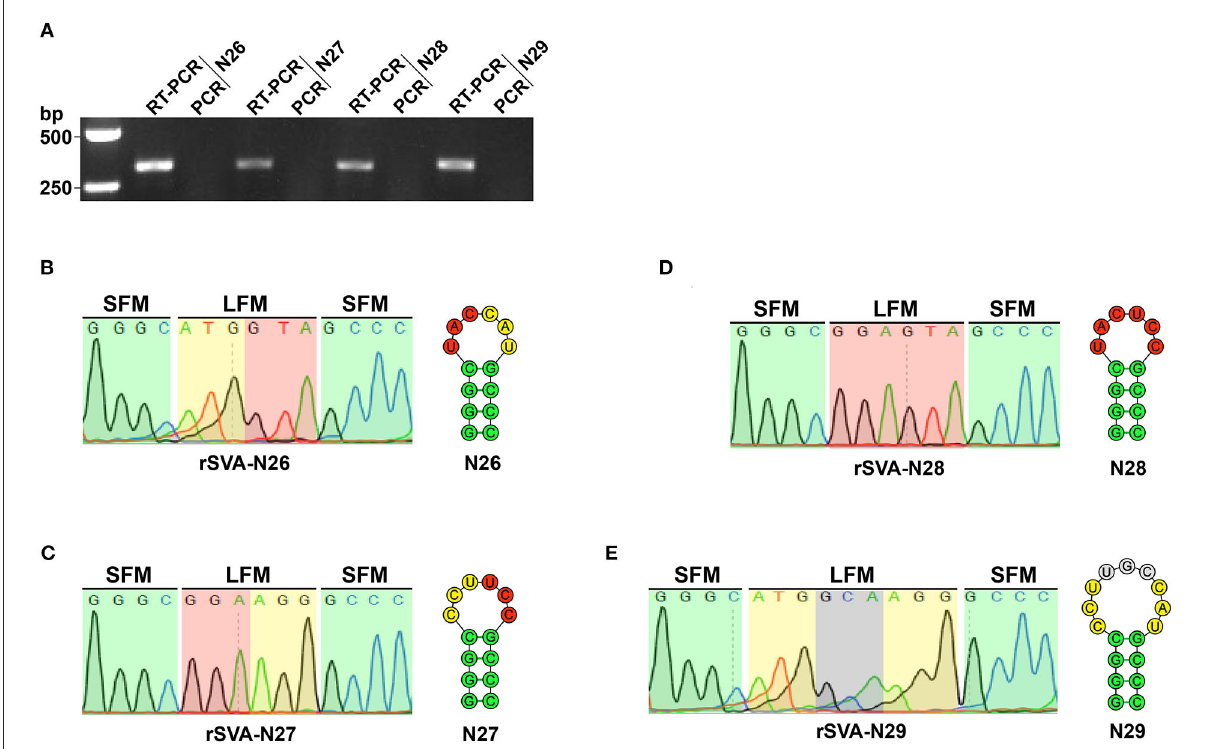
FIGURE6 Detection and characterization of rSVA-N26 to -N29. RT-PCR analysis of rSVA-N26 to -N29 at P6 (A) . PCR controls are assigned to demonstrate no interference of plasmid residues. Sanger sequencing for hairpin-1-forming motifs of rSVA-N26 to -N29 at P6 (B–E) . Since the reverse primer (RP4) is used for Sanger sequencing, four chromatogram-exhibited fragments are reverse-complement sequences of hairpin-1 motifs. Green, yellow, red and gray shadow-covered chromatograms (rSVA-N26 to -N29) match to green, yellow, red and gray circle-marked fragments in the hairpin-1 (N26 to N29), respectively. LFM, loop-forming motif; SFM, stem-forming